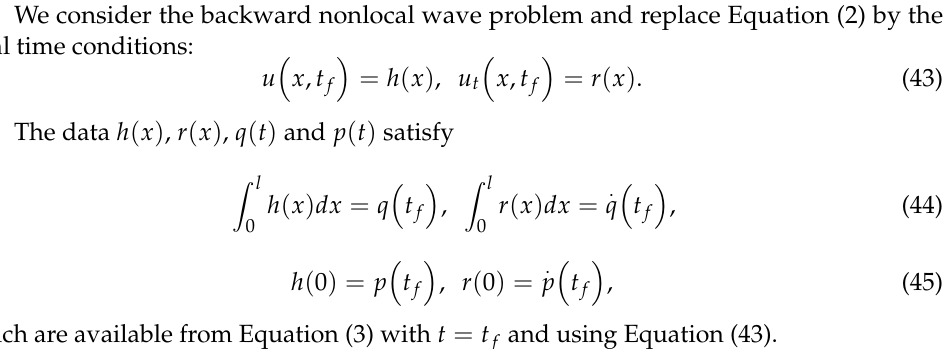
Figure 9. For Example 4: ME( u ) versus x at t f = 5. Numerical Method for Backward Nonlocal Wave Problem